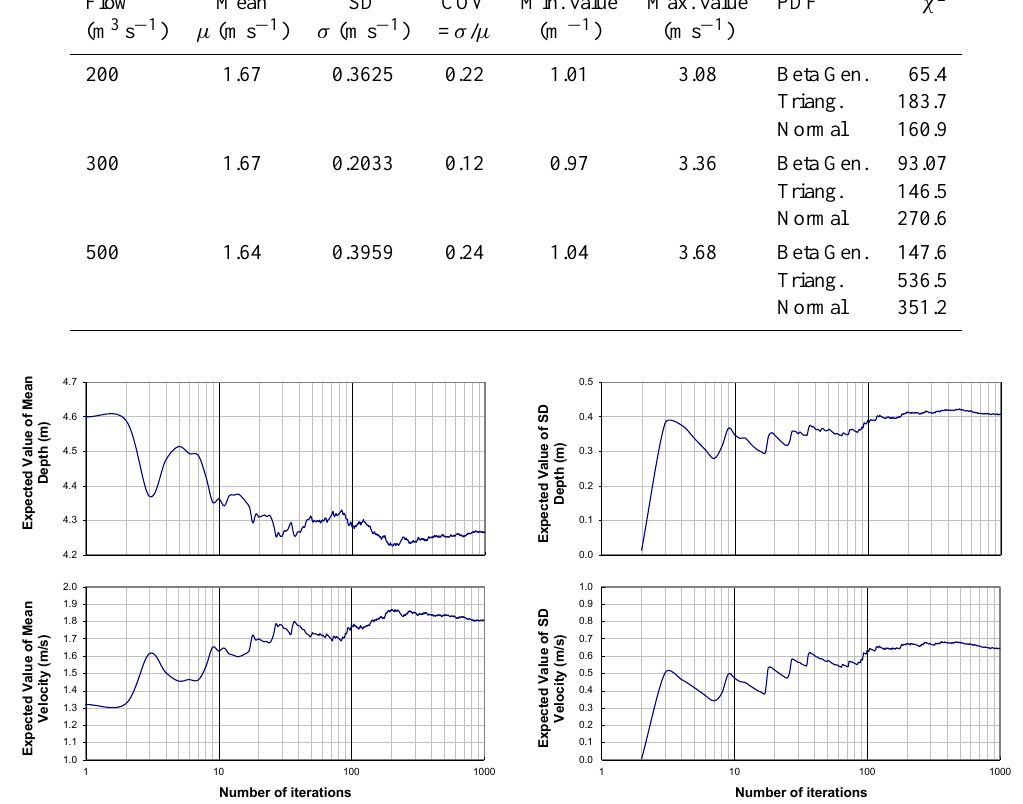
Fig. 5. Uniform flow model. Convergence of mean and standard deviation values for water depth and velocity. Case of n i uniformly distributed and flow case 500m 3 s − 1